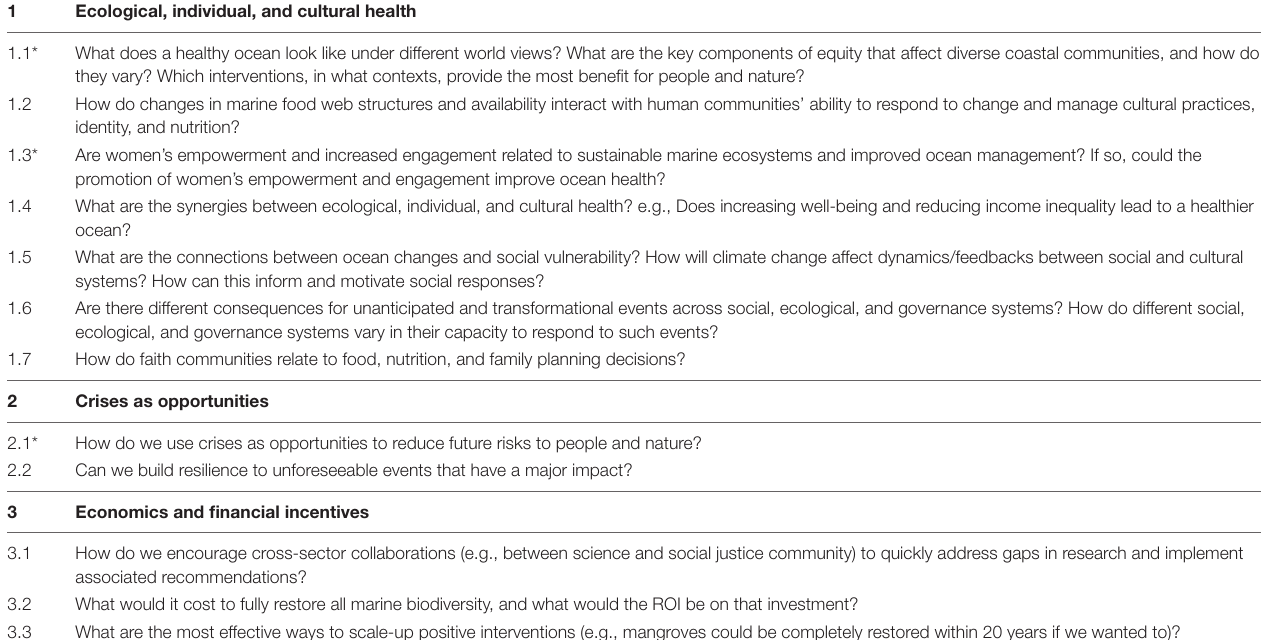
TABLE 1 | Nine priority research areas and 46 research questions for promoting healthy marine ecosystems and human